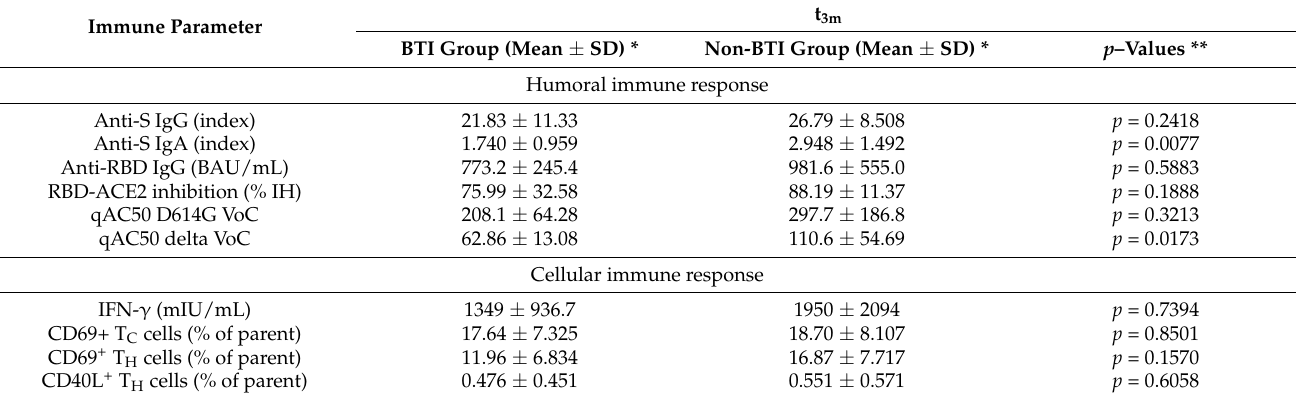
Table 3. Comparison of both SARS-CoV-2-specific humoral and cellular parameters between the BTI and non-BTI group measured 3 months after BNT162b2